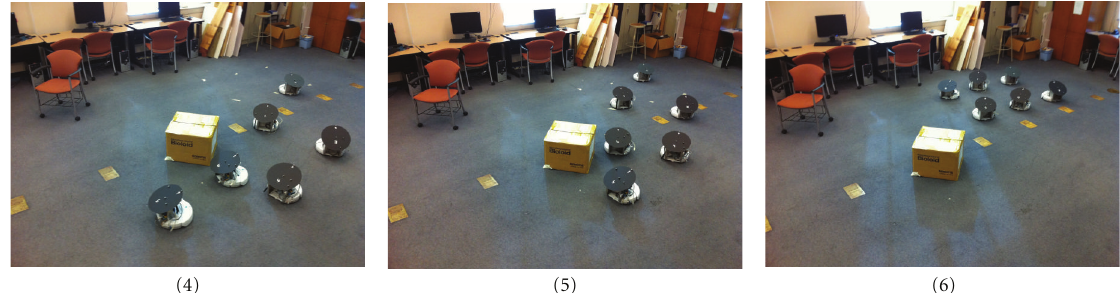
Figure 13: Three sequential snapshots of the 6 iRobot Creates executing the motion planner presented in this paper. Frame 6 is the goal